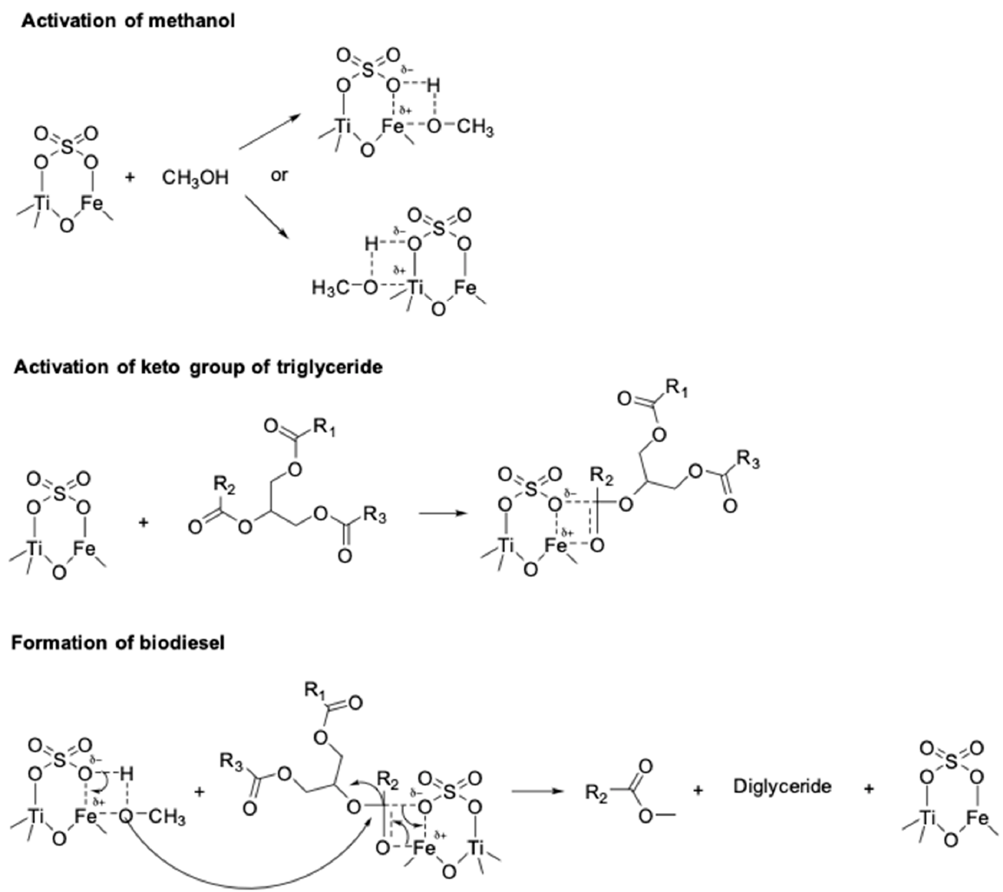
Figure 10. Mechanism of transesterification over sulfated Fe 2 O 3 -TiO 2 .